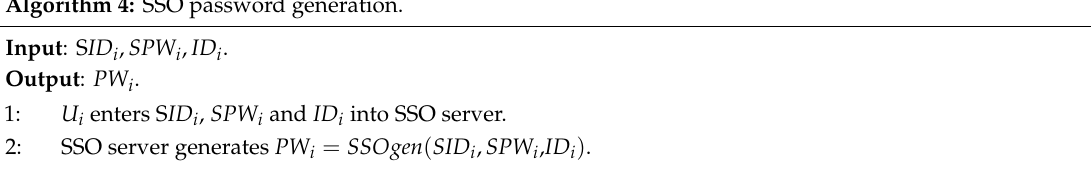
Algorithm 4: SSO password